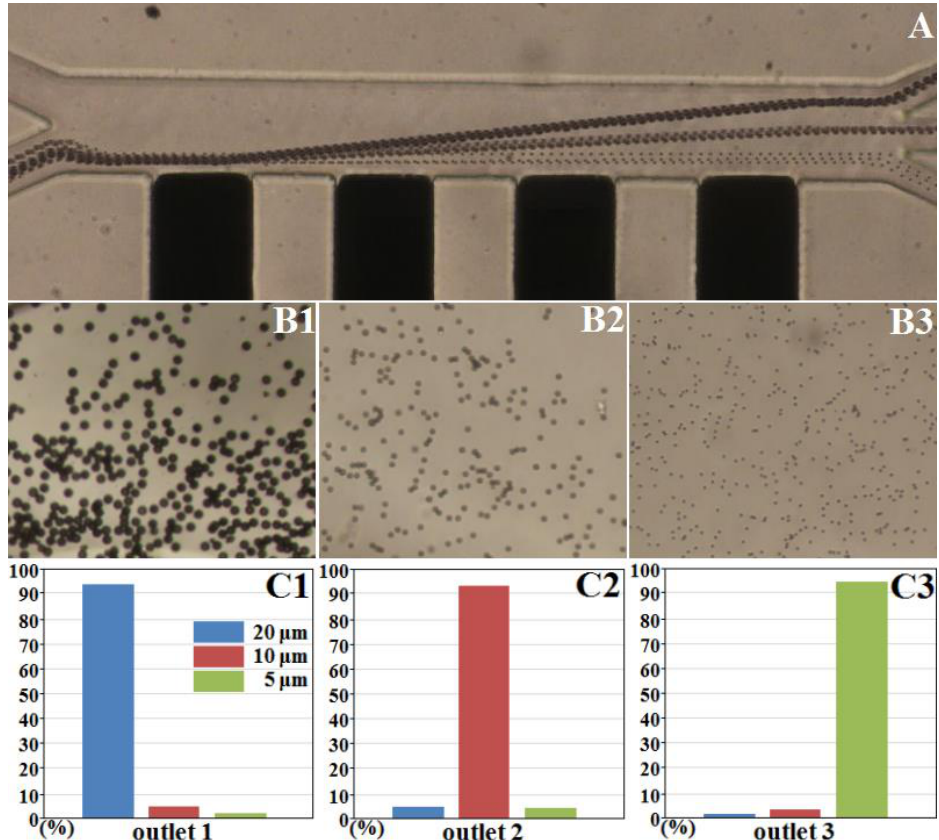
Figure 5. ( A ) Continuous separation of polystyrene particles of three sizes via nDEP. ( B1 – B3 ) Separated particles at the chambers of outlets 1, 2, and 3, respectively. ( C1 – C3 ) Histograms indicating the percentages of the three types of particles in each outlet.